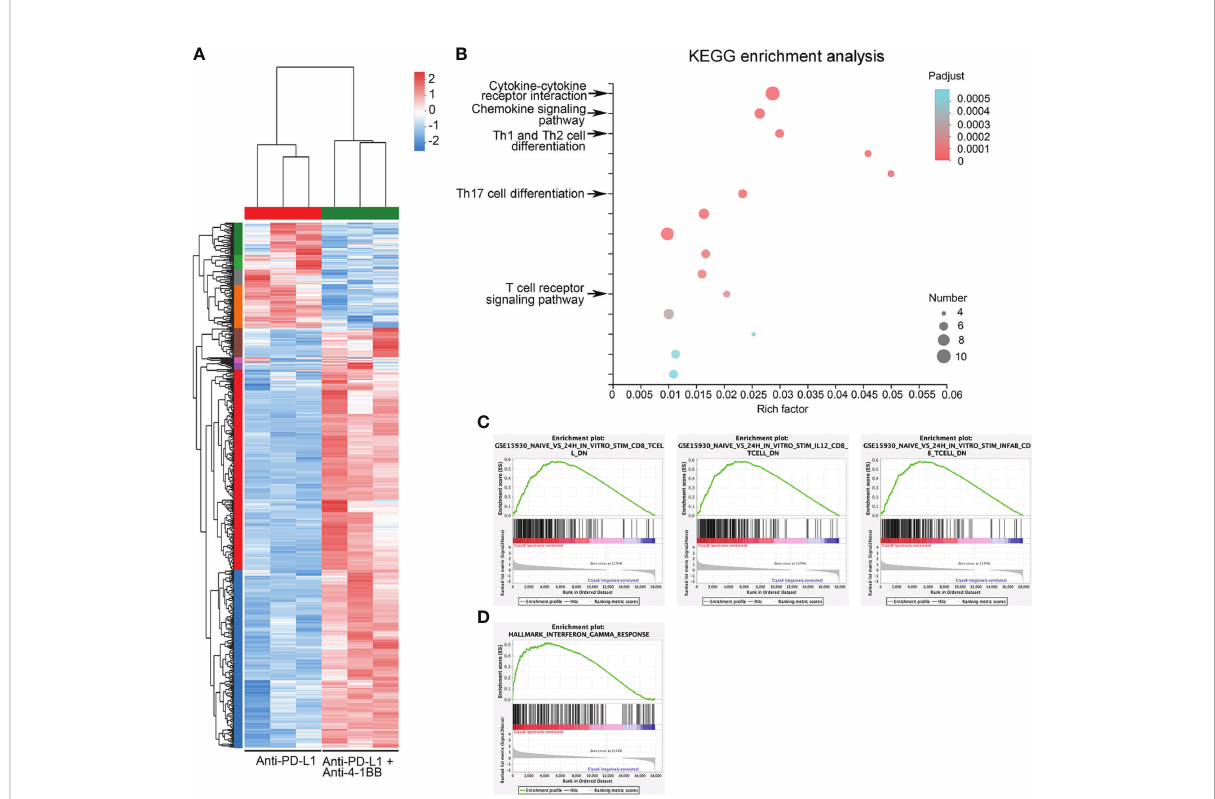
FIGURE 2 Mechanisms underlying the synergistic antitumor ef fi cacy of the combination therapy. (A) Heatmap showed the differentially expressed genes between the anti-PD-L1 group and the combined therapy group. (B) Enrichment of KEGG pathway of differentially expressed genes. (C) GSEA showed an enrichment of the gene set related to CD8 + T cell activation. (D) GSEA showed enrichment of activation of IFN- g response gene